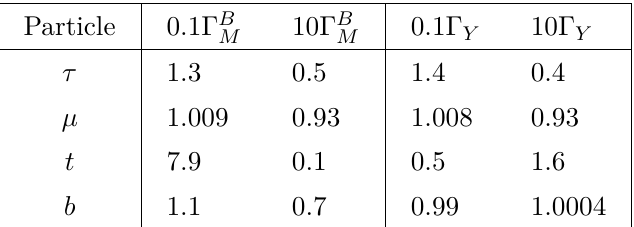
Table 1. The ratio Y mod /Y B of the modified to unmodified predictions of the baryon asymmetry, B for particular values of the modifier κ . Every modification is made only with the corresponding M/Y active source term. Effects of modifications to relaxation rates of species with no active source is smaller than for the particle with the active source.